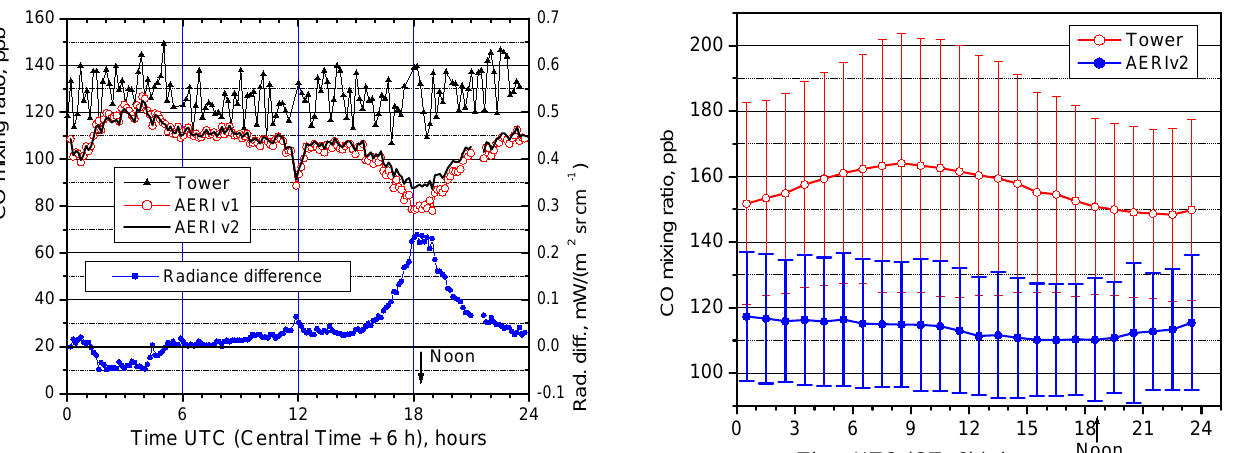
Fig. 11. Average 2006 diurnal cycles for in situ measurements at the 60-m-tall tower and CO retrieved from the AERI v2. Vertical bars are the standard deviations of hourly